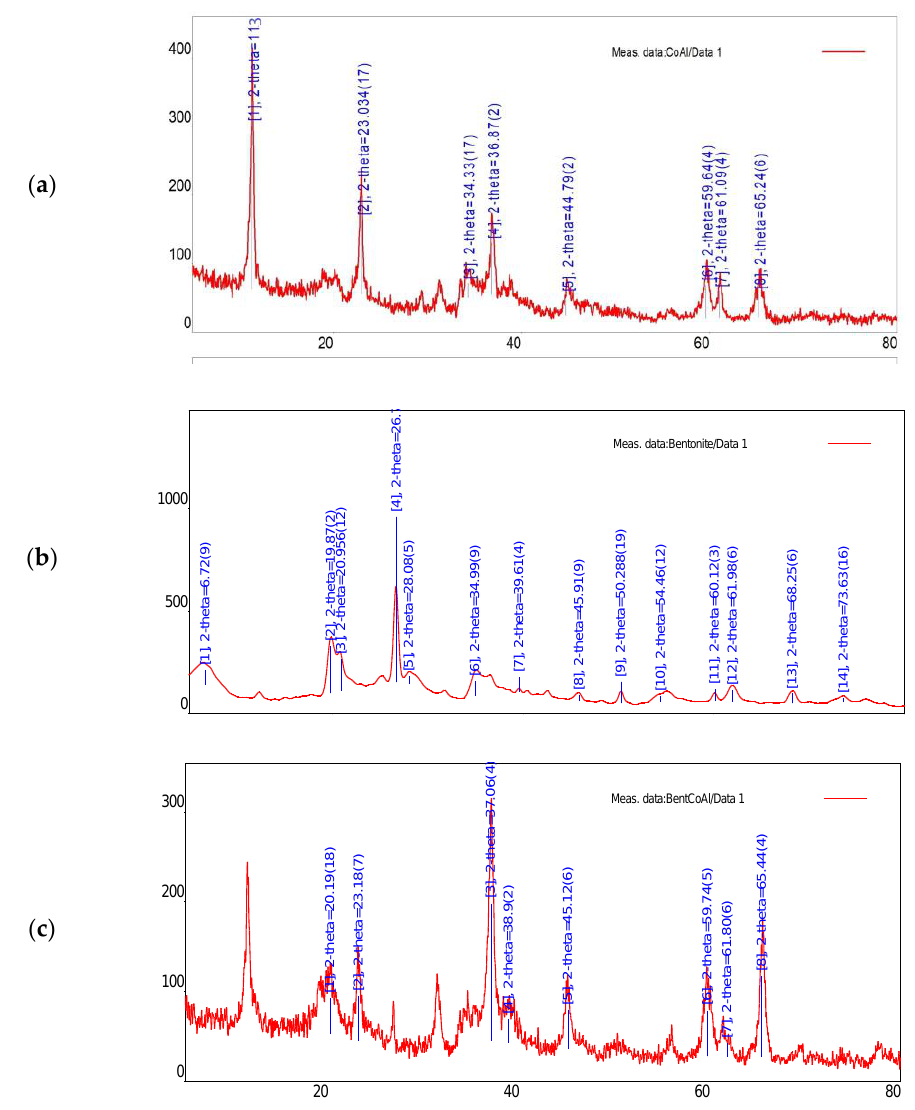
Figure 4. XRD for ( a ) raw bentonite ( b ) CoAl-LDH and ( c ) bentonite-CoAl-LDH. The thermal stability of the bentonite-CoAl-LDH adsorbent was investigated using TGA analysis between temperature range of 20–800 ◦ C as presented elsewhere [9]. The result indicates adsorbent weight loss of around 20–23% between 20 to 200 ◦ C. This observa- tion can be attributed to the initial loss of bounded water molecules. When the temperature was increased to 300 ◦ C, observed weight losses were around 54%, suggesting a good adsorption